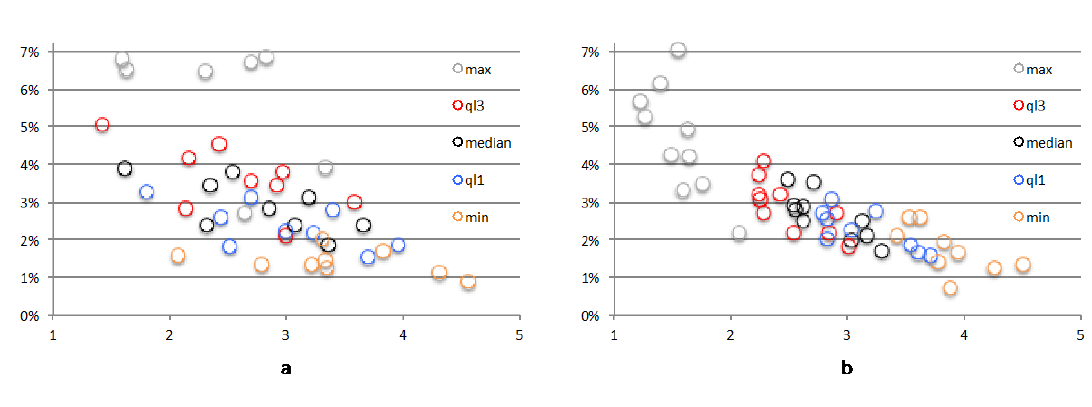
Figure 15. Cap rates and overall quality by cluster ( a ) and by neighbourhood ( b ).